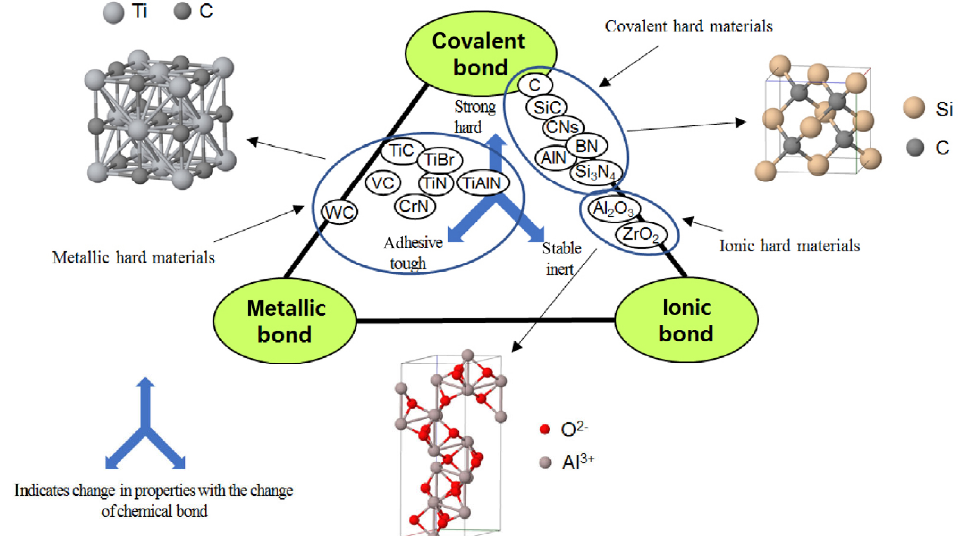
Fig. 1 Classification of different groups of hard ceramic materials on their bonding type and crystalline structure. Adopted from Ref. [6], with permission from